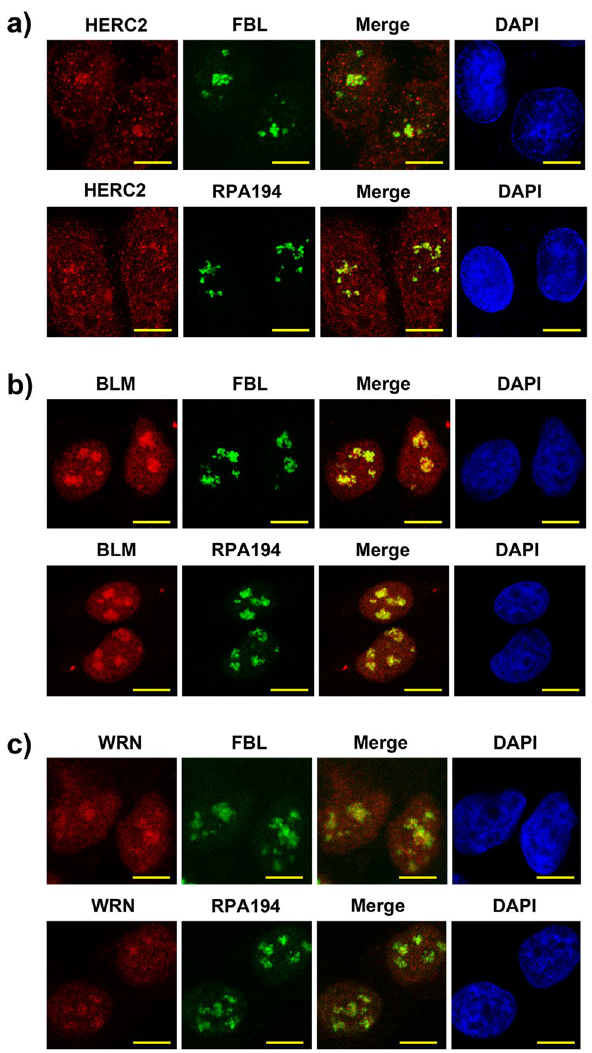
Figure 4. HERC2, BLM and WRN co-localize with FBL and RPA194. Spontaneously growing HeLa cells are subjected to immunostaining with HERC2 (a) , BLM (b) or WRN (c) coimmunostained with FBL (upper panels) or RPA194 (lower panels) as indicated. The nuclei were counter stained with DAPI. Scale bar, 10